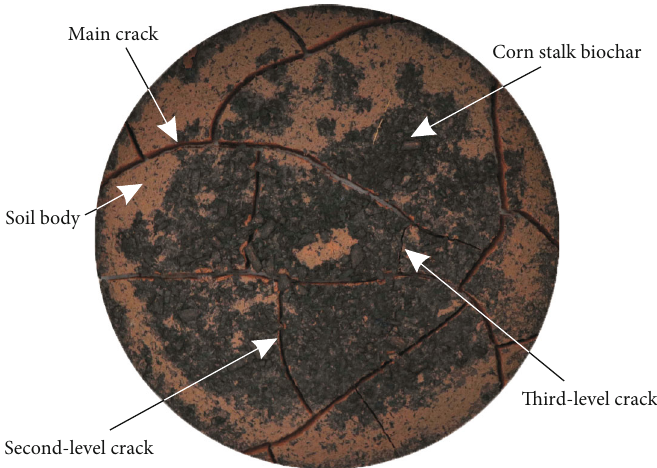
Figure 2: Final development of crack